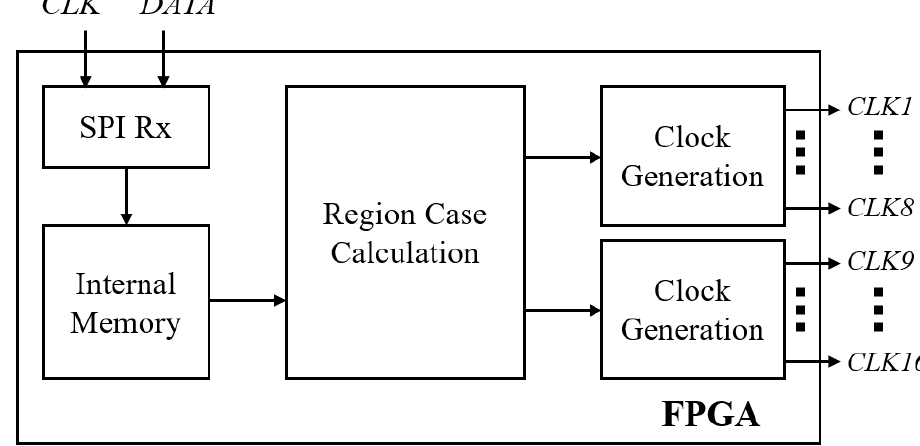
Figure 10. Block diagram of variable clock generation in a field programmable gate array (FPGA)